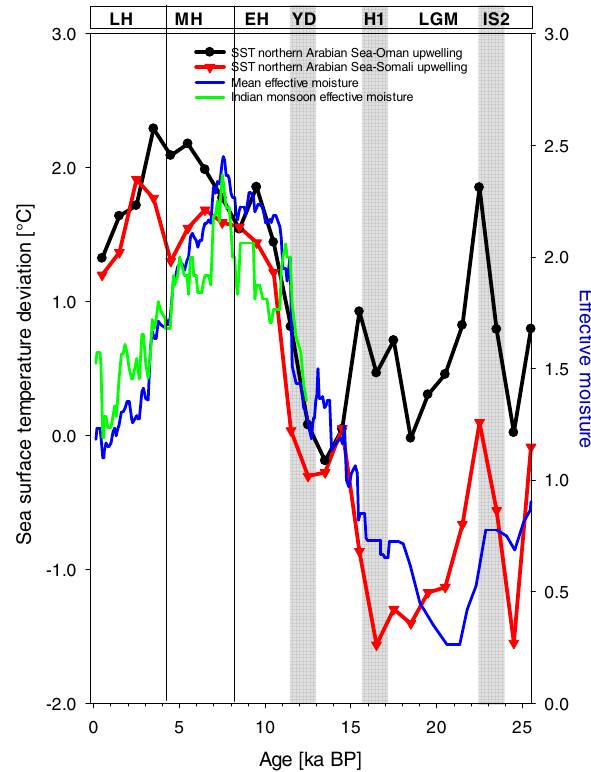
Figure 7. Millennial regional-averaged SST from the northern Ara- bian Sea minus Oman-upwelling-averaged SST in ◦ C (black line) and northern Arabian Sea minus Somali-upwelling-averaged SST (red line; regions are indicated in Fig. 1) compared with reconstruc- tions of the mean effective moisture in southern and central Asia (blue line) and the Indian monsoon region (green line) from conti- nental archives (Herzschuh, 2006). Grey bars and abbreviations as in Fig.